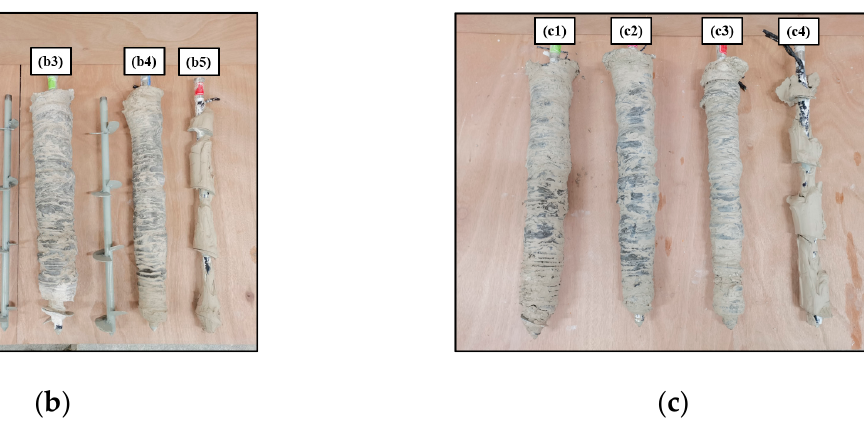
Figure 9. Shape of the soil-cement column of each small-scale pressure-grouted helical pile, ( a ) helix number test sets: ( a1 ) PGHP-HN-2, ( a2 ) PGHP-HN-3, ( a3 ) PGHP-HN-4, ( a4 ) PGHP-HN-4 (U), and ( a5 ) HP-HN-4; ( b ) Helix Size test sets: ( b1 ) PGHP-HS-44, ( b2 ) PGHP-HS-66, ( b3 ) PGHP-HS-88, ( b4 ) PGHP-HS-66 (U), and ( b5 ) HP-HS-66; ( c ) drilling speed test sets: ( c1 ) PGHP-DS-200, ( c2 ) PGHP-DS-250, ( c3 ) PGHP-DS-300, and ( c4 ) HP-DS-250.